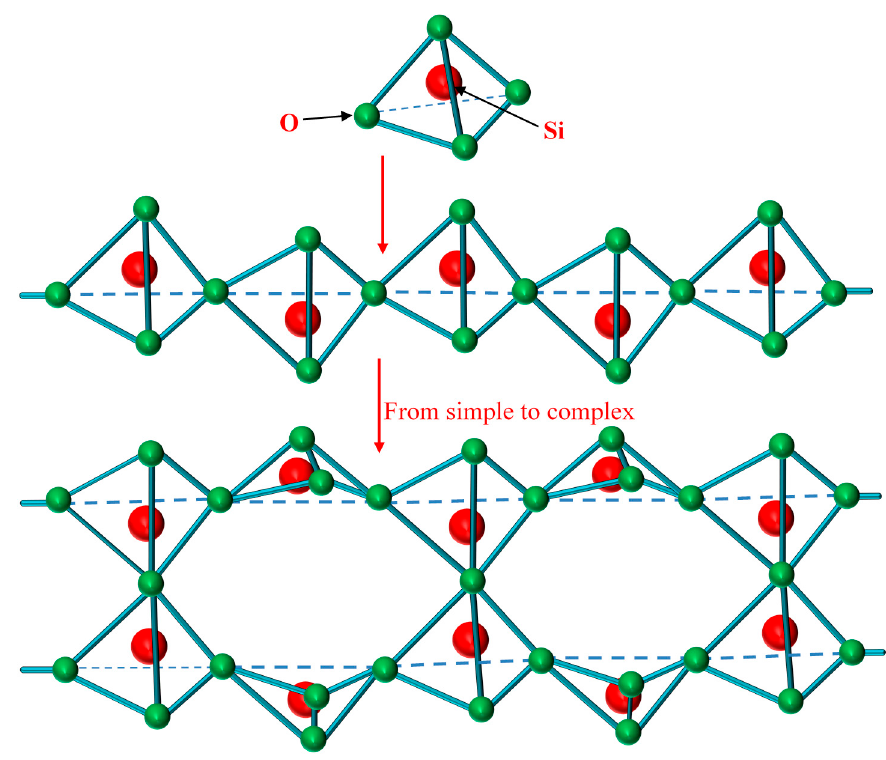
z − structure. Figure 9. Transformation process of the Si x O y y